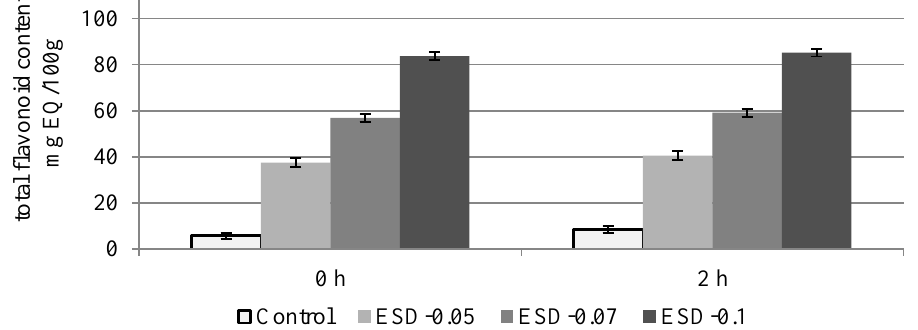
Figure 4. The content of flavonoids in the dough samples. Each value is presented as mean ± standard deviation ( n = 3).